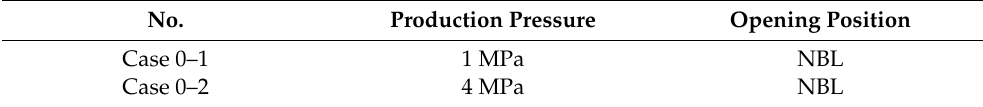
Table 2. Main production parameters for the control group cases.